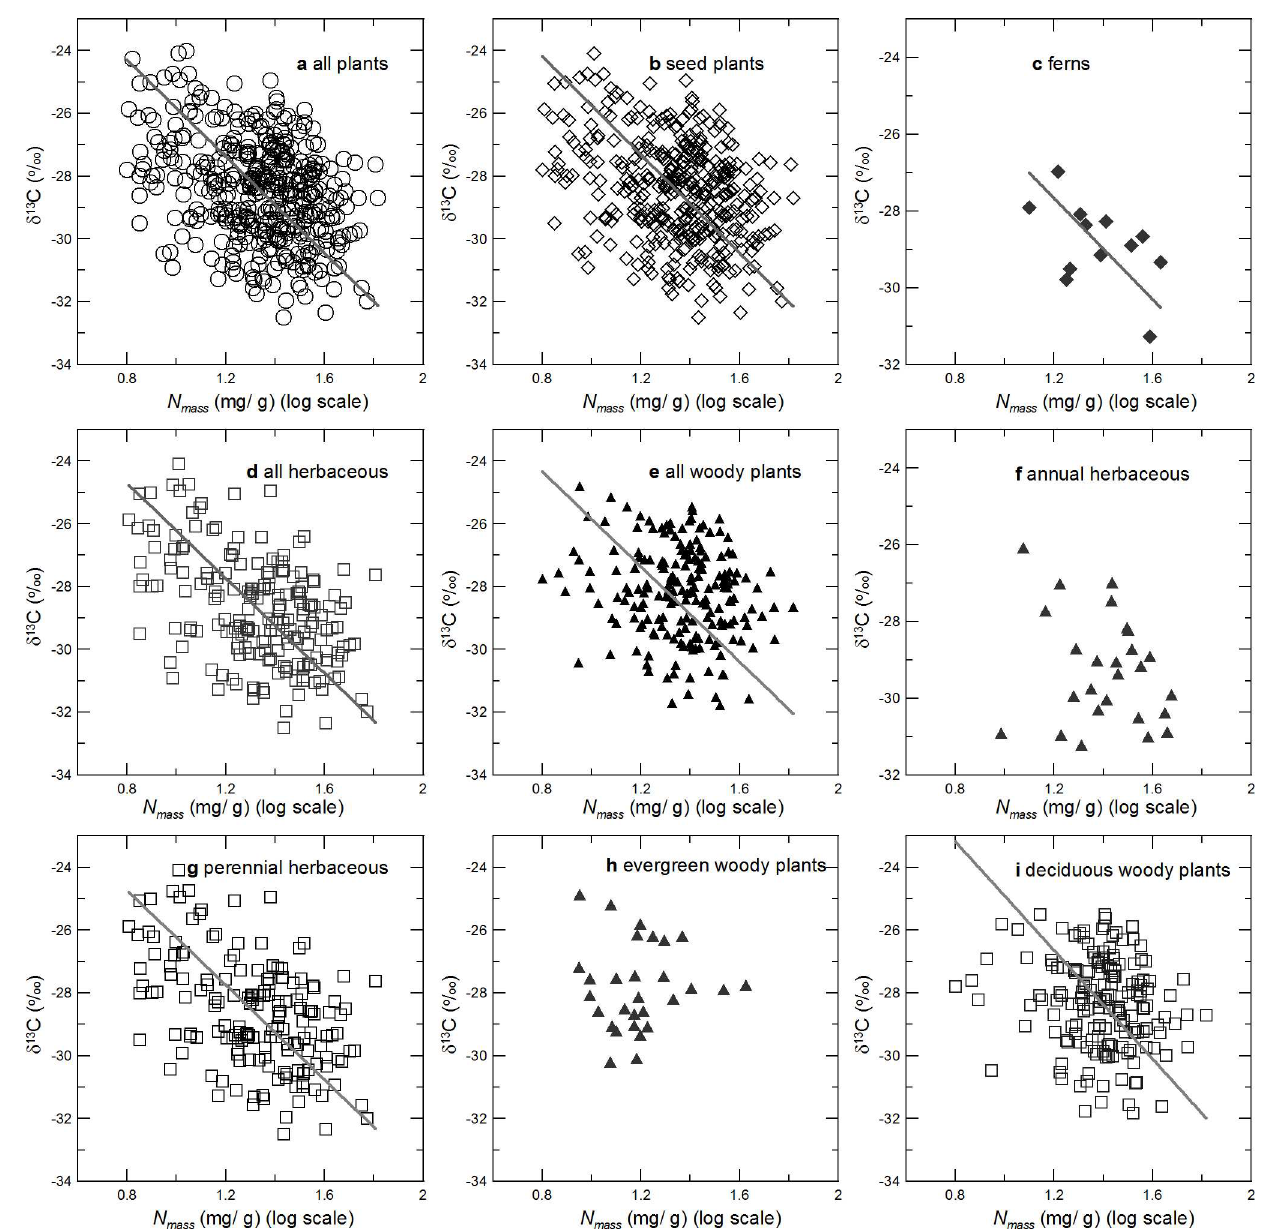
Fig 3. Correlation between leaf δ 13 C and leaf N mass for different plant groups.